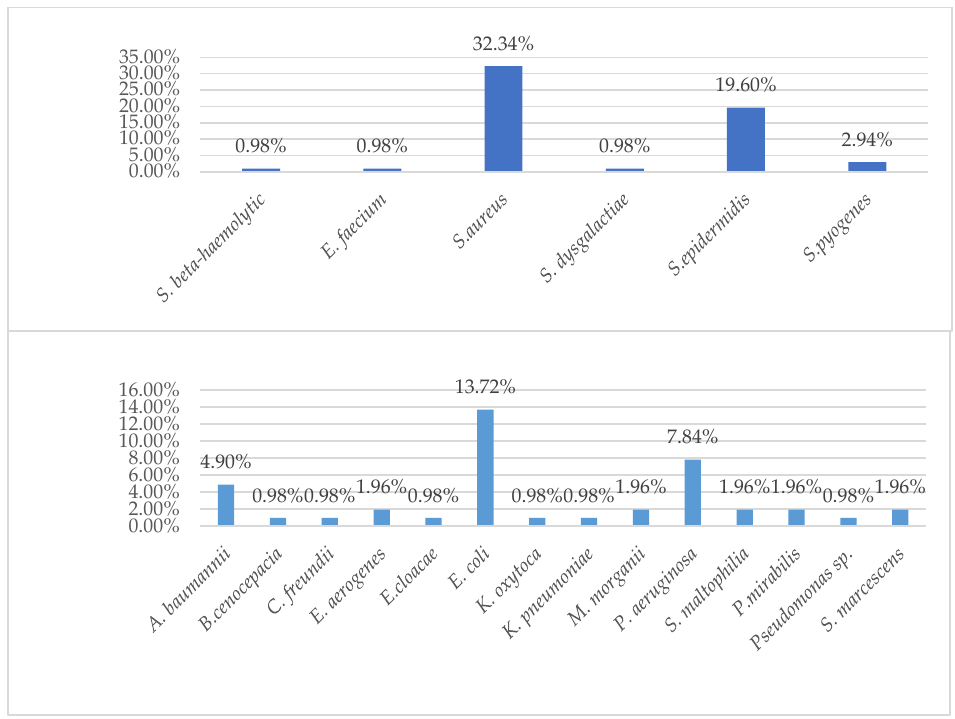
Figure 2. Etiology of soft tissue infections in Karaganda, Kazakhstan, 2018 – 2020, adults. Abbrevia-